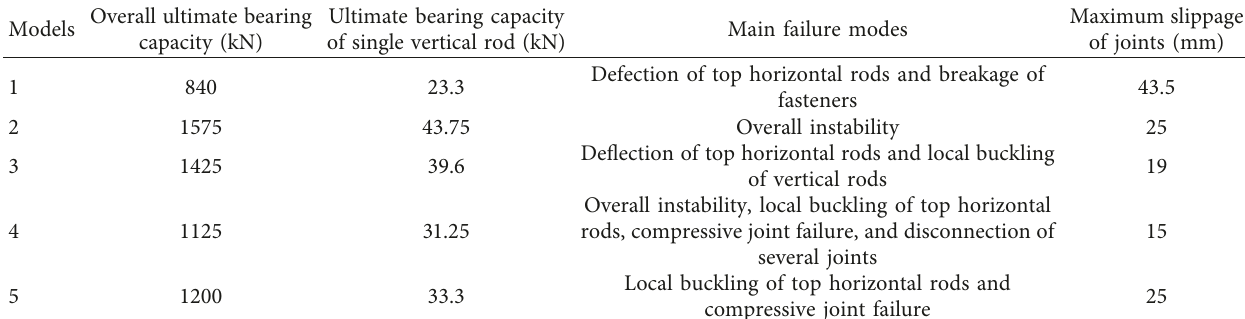
Table 4: Summary of bearing capacity and failure modes of experimental models.